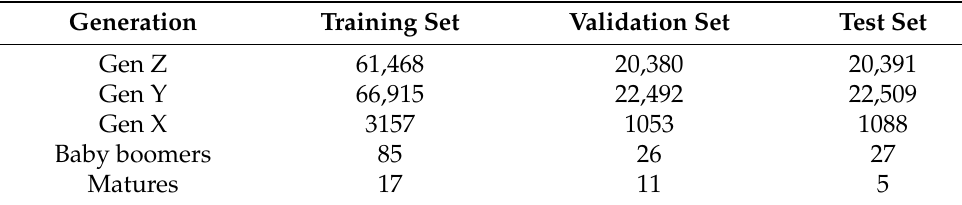
Table 7. Number of samples by age group and